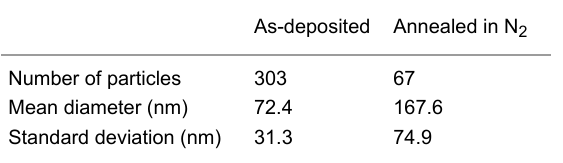
Table 2: Summary of the particle distribution presented in Figure